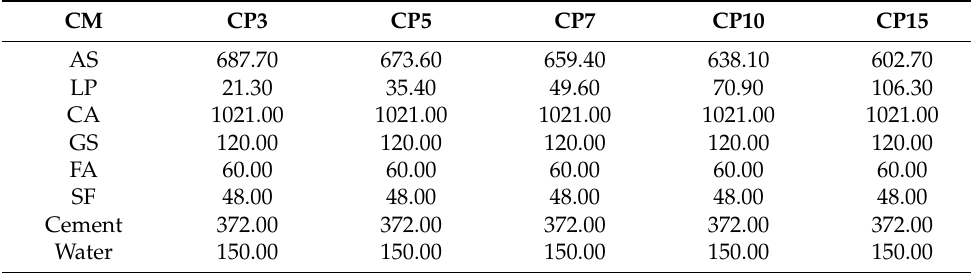
Figure 1. Steel fibers physical map. Table 5. Mixture proportions of C80 concrete (kg/m 3 ). Table 2. Granulometry test for coarse aggregate.